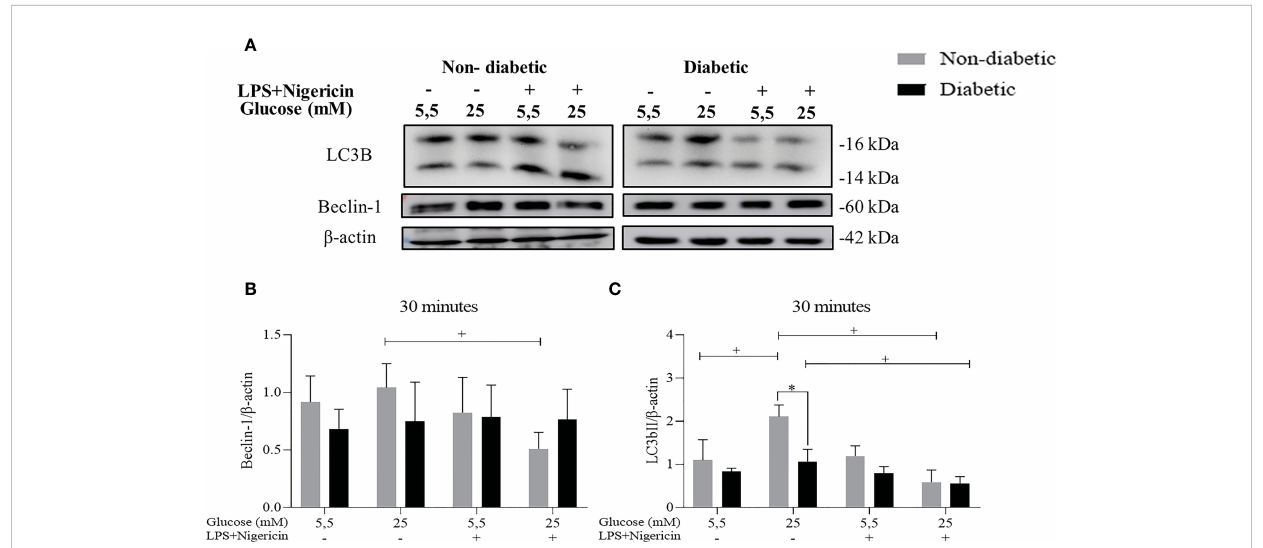
FIGURE 3 Evaluation of the autophagy pathway. (A) Expression (B) Beclin-1/ b -actin protein level within 30 minutes. +P<0.05 ND-BMDM 25mM- vs ND-BMDM 25mM+; (C) LC3b/ b -actin protein level after 30 minutes of treatment. +P<0.05 ND-BMDM 5.5mM- vs ND-BMDM 25mM-; +P<0.05 ND-BMDM 25mM- vs ND-BMDM 25mM+; +P<0.05 D-BMDM 25mM- vs D-BMDM 25mM+; *P<0.05 ND-BMDM 25mM- vs D-BMDM 25mM-. Results represent mean ± SEM. N = 3-6. BMDM: Bone-Marrow Derived Macrophages, from diabetic (D-) and non-diabetic (ND-) C57BL/6 mice.